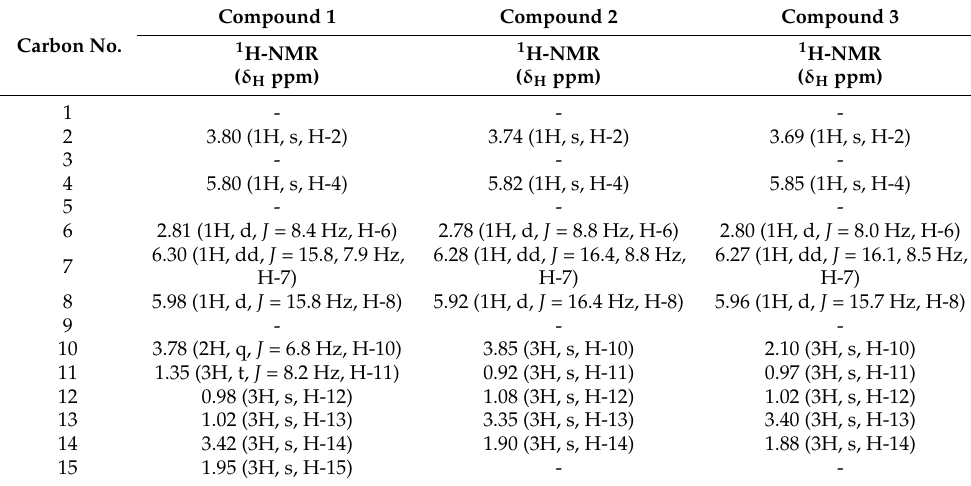
Table 1. 1 H NMR (500MHz, CDCl 3 ), δ H in ppm.